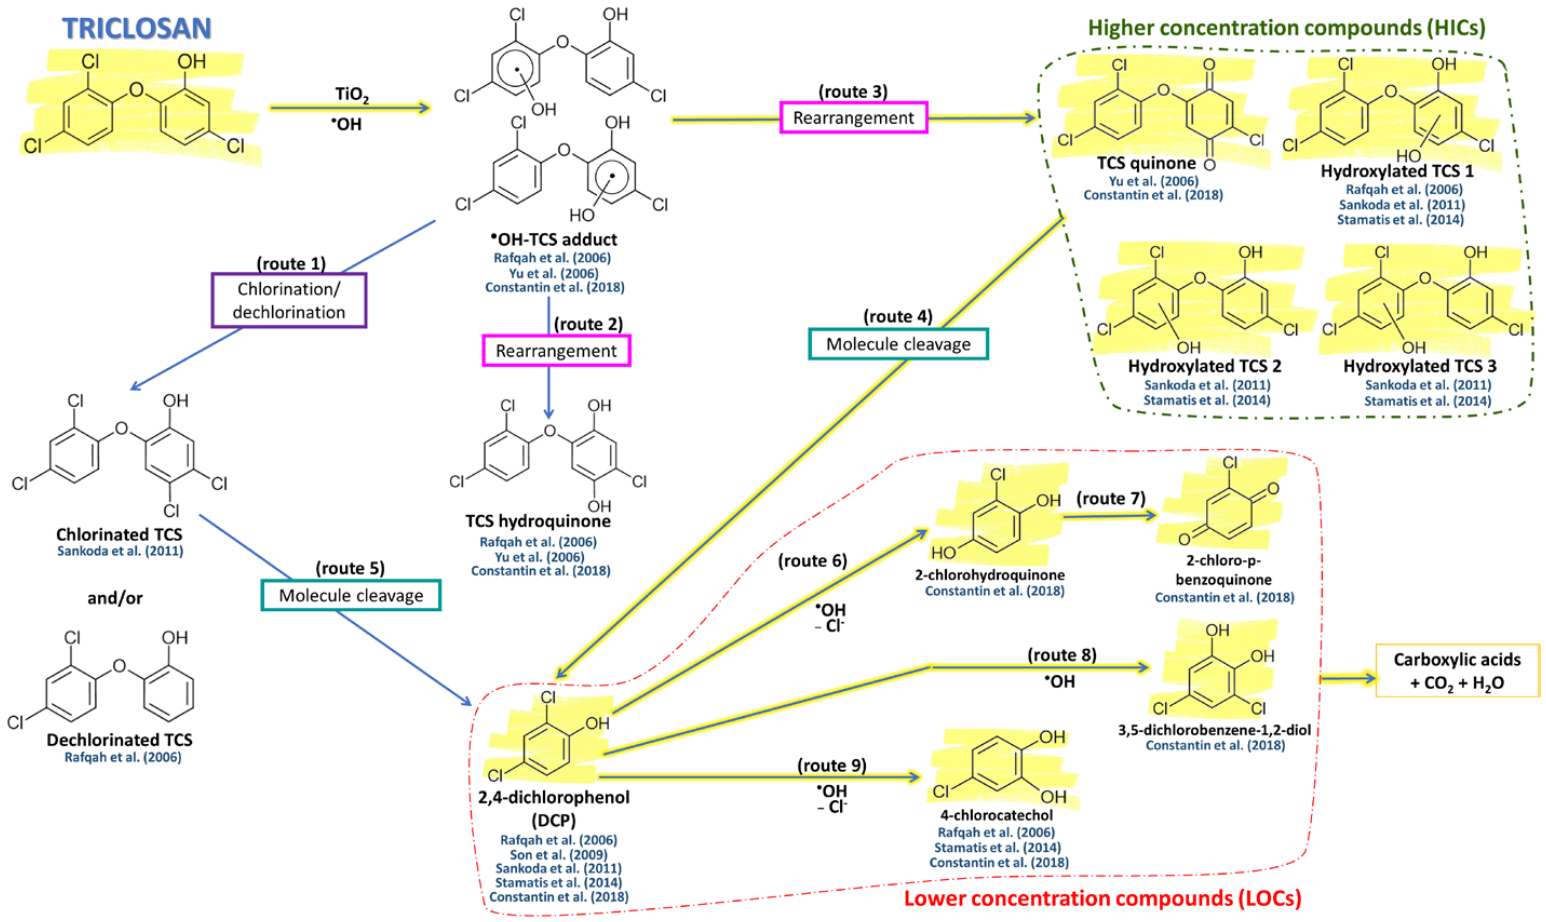
Figure 2. Summary of the main photodegradation mechanisms of Triclosan (TCS). Detected in this work. Adapted from the literature [32,35–37,39,41,42].